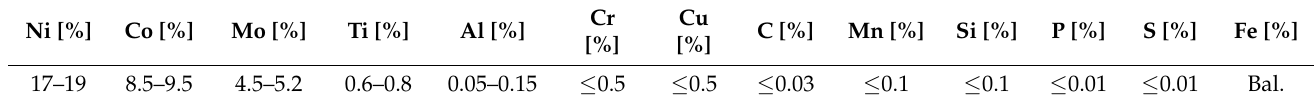
Table 1. Chemical composition (weight percentage) of maraging steel